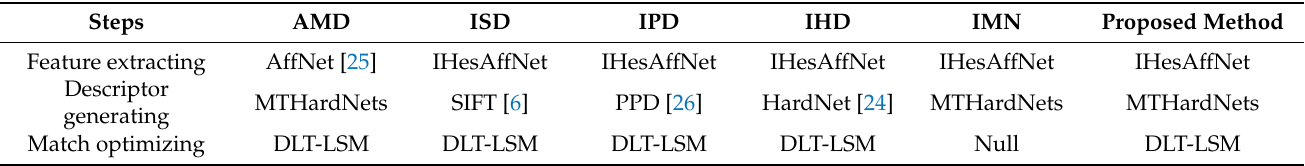
Table 4. List of six different methods, namely, the AMD, the ISD, the IPD, the IHD, the IMN, and the proposed method.